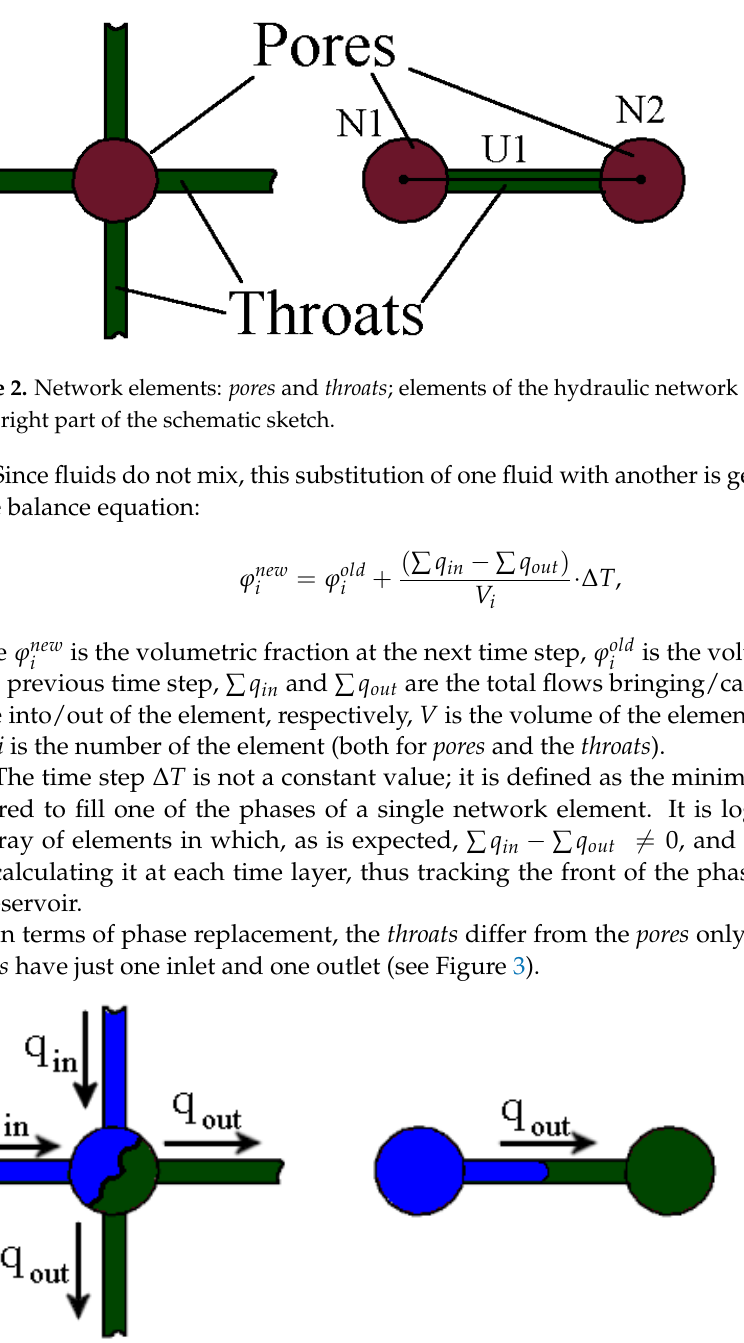
Figure 3. Phase substitution in the pore and the throat. Color: green — oil, blue — displaced fluid.